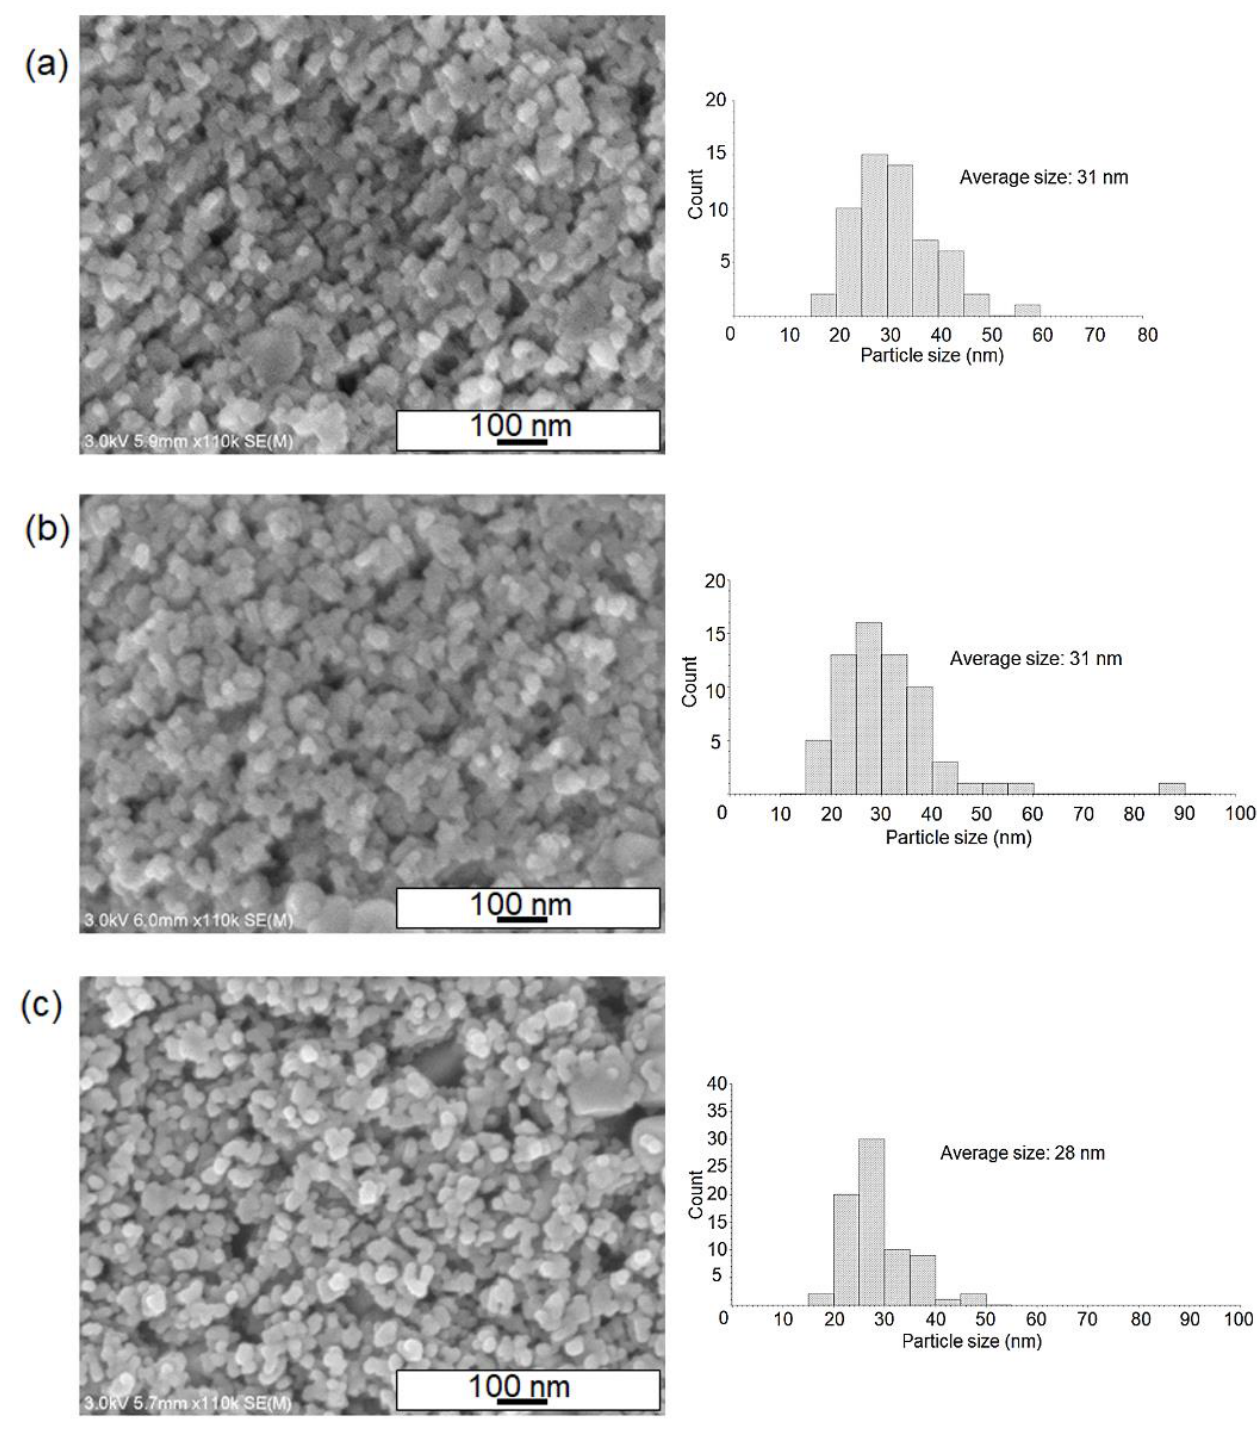
Figure 4. SEM images of the surface of TiO 2 films after nanofluid pool boiling, where the post sintering strategies have been changed. Sintering strategies (maximum temperature, ramping rate, and the period of maximum temperature): ( a ) without sintering, ( b ) 250 °C, 1 °C/min, 1 h, ( c ) 300 °C, 1 °C/min, 6 h. Particle size distributions of the nanoparticles were also presented.